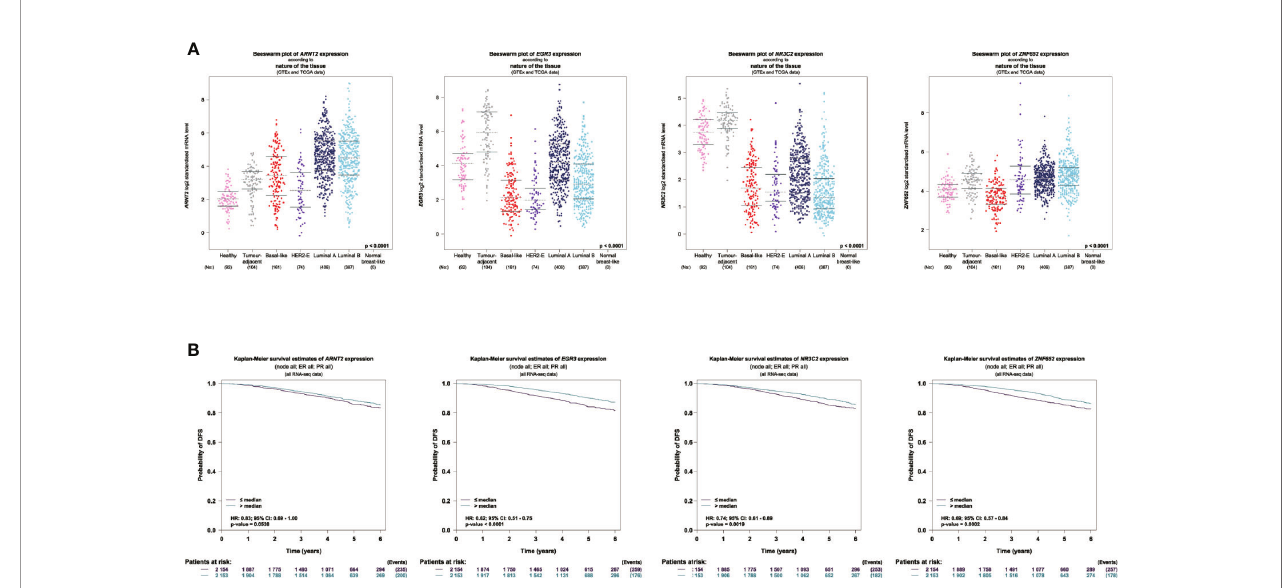
FIGURE 3 | Expression and prognostic values of candidate TFs in breast cancer. (A) Visualization of the expression pro fi le of the 4 TFs in normal breast sample and breast tumor. (B) Survival analysis of 4 TFs regarding DFS using TCGA and SCAN-B data.